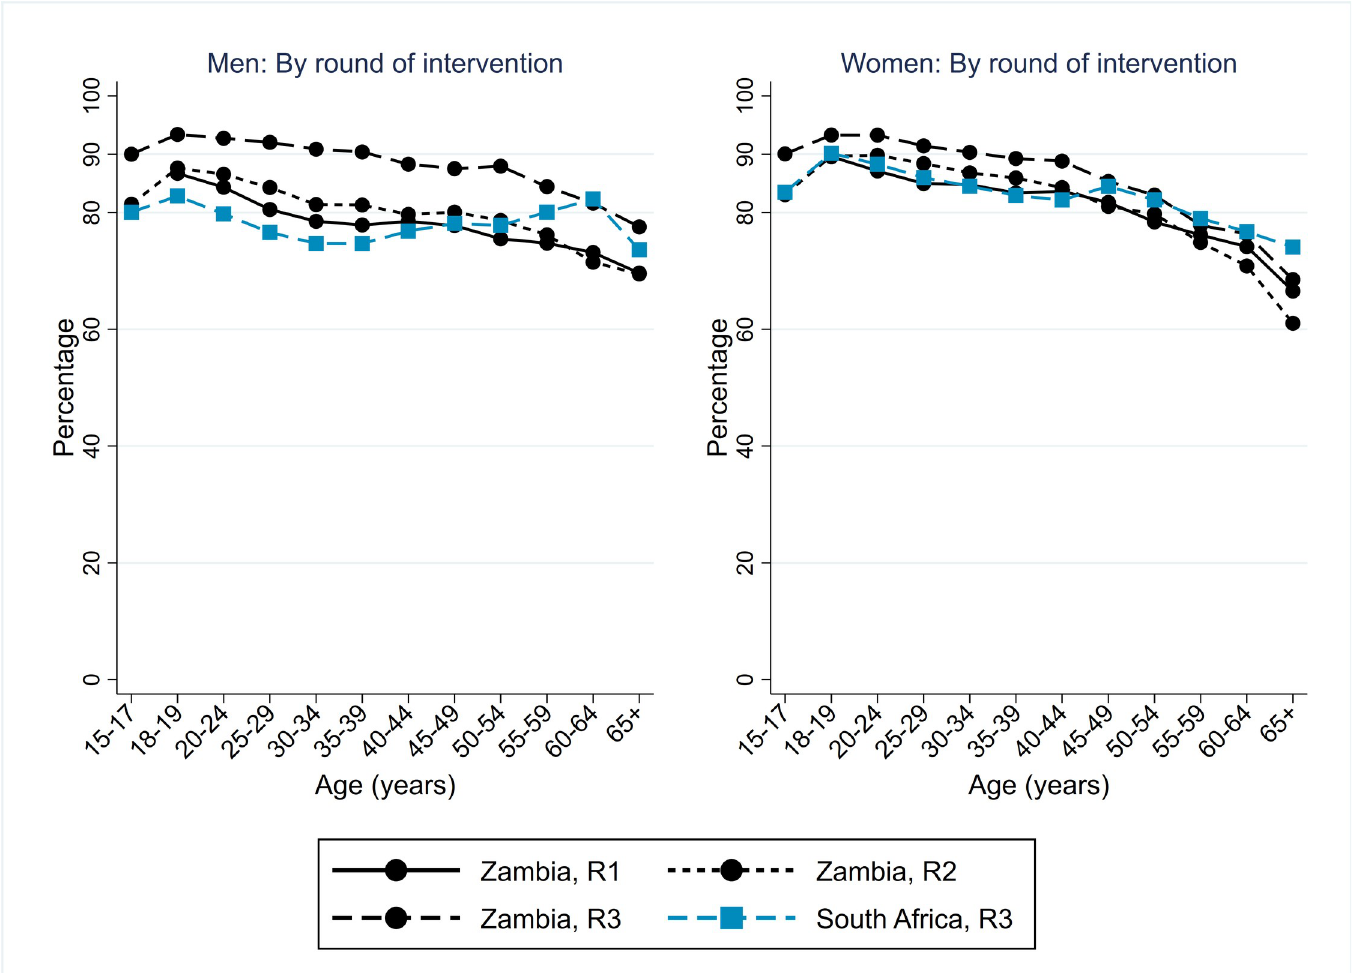
Fig 3. Arm A: Knowledge of HIV status following participation in the PopART intervention, Zambian communities R1–R3, and SA communities R3, by sex and age group. R1, Round 1; R2, Round 2; R3, Round 3; SA, South Africa.